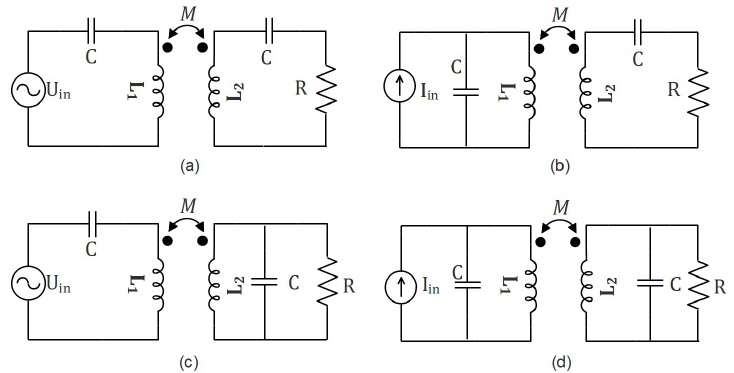
Figure 2. Basic compensation networks ( a ) series-series, ( b ) parallel-series, ( c ) series-parallel, and ( d )